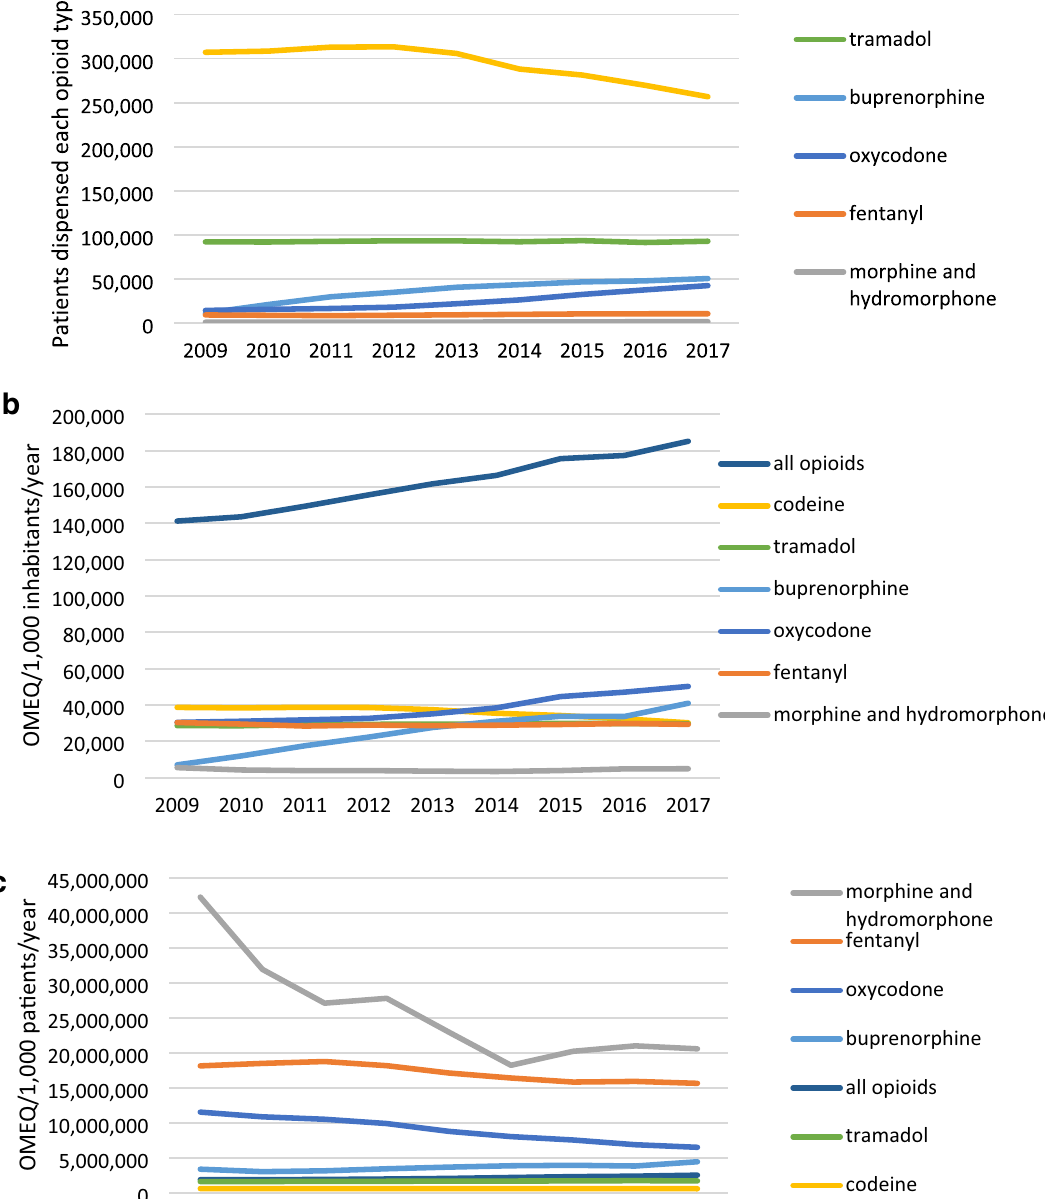
For weak opioids, the use of codeine combinations decreased during 2009-2017 in terms of patient num- bers and dispensed quantity per 1,000 inhabitants, with a relatively unchanged dispensed quantity per patient (Fig. 2a–c). For strong opioids, out-patient use of fentanyl and (hydro)morphine remained stable during the inspection period of 2009-2017, with a decreasing mean dispensed quantity per patient for both opioid classes. While the patient numbers for both buprenorphine and oxycodone increased, the mean amounts dispensed took opposite